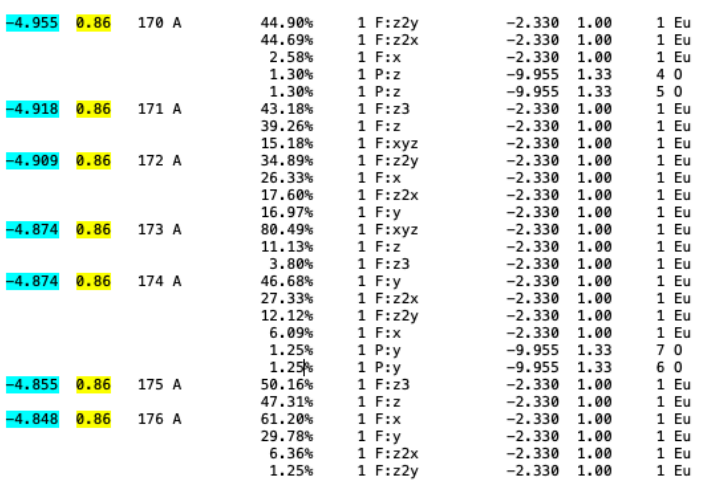
Figure 2. Selective section of the ADF output for the calculation of [Eu(NO 3 ) 3 (phenanthroline) 2 ] by using DFT with the hybrid PBE0 functional, showing the energy of the seven MOs in eV (in blue) that have larger atomic Eu 4 f parentage together with the electron occupation number (in yellow) that are assigned with the MOs. The right-hand-side of the figure shows the percentage characters of the MOs based on Mulliken population